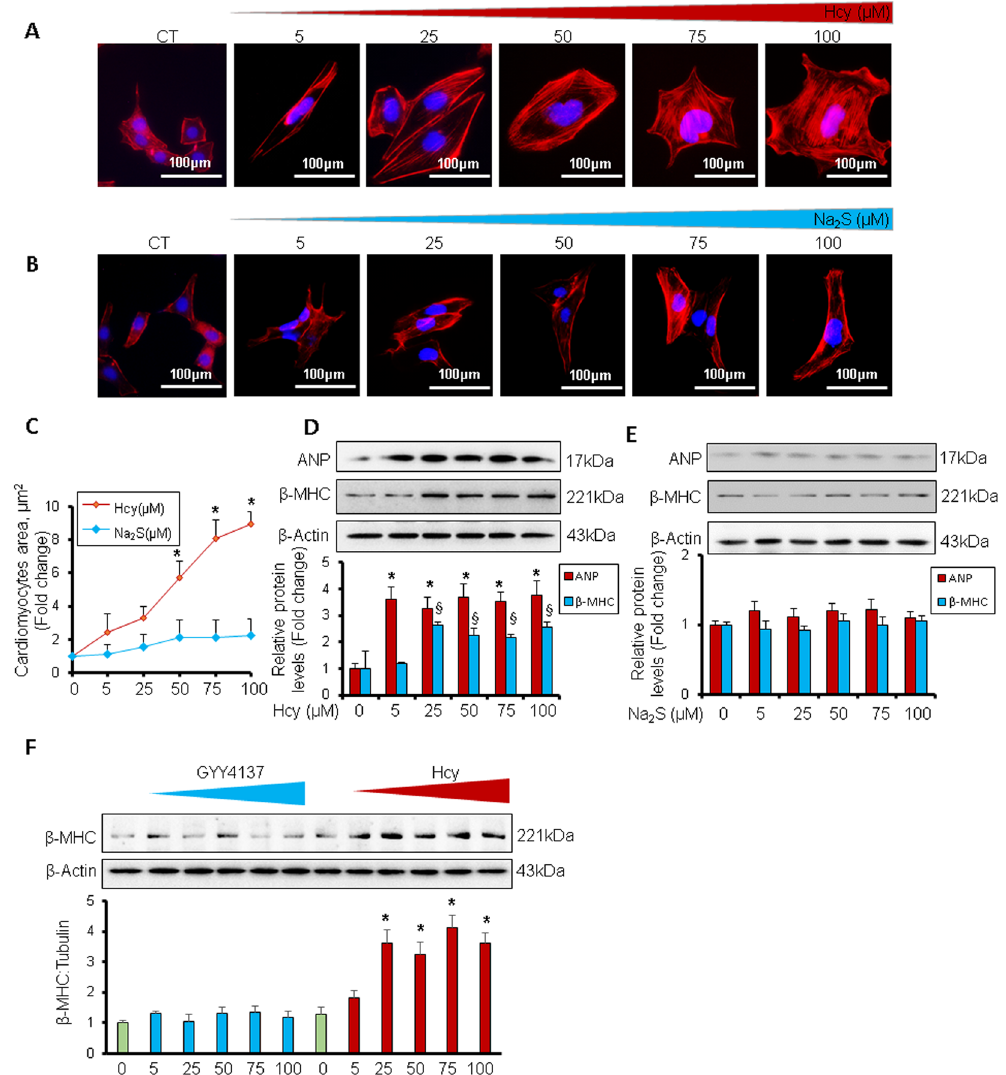
Figure 5. Dose-dependent effect of homocysteine or hydrogen sulfide donor Na 2 S/GYY4137 on hypertrophy in HL1 cardiomyocytes. ( A ) Representative F-actin staining for cardiomyocytes treated with different doses of Hcy, and ( B ) Na 2 S. ( C ) Quantification of cardiomyocytes area showing the increase in the area of cardiomyocyte surface after treatment with different dosages of Hcy or Na 2 S. Values are represented as mean ± SEM, n = 20 cells per group from three independent experiments. “ * ” Represents statistical significant value when compared to the untreated control. ( D ) Western blot analyses of atrial-natriuretic peptide (ANP) or beta-myosin heavy chain ( β -MHC) after treatment with different dosages of Hcy or, ( E ) Na 2 S, or ( F ) GYY4137. Values are represented as mean ± SEM. “ * ” Represents statistically significant value for ANP when compared to the untreated control, and “§” represents statistically significant value for β -MHC when compared to the untreated control. p < 0.05 is considered statistically significant. Scale bar: 100 μ m. N =